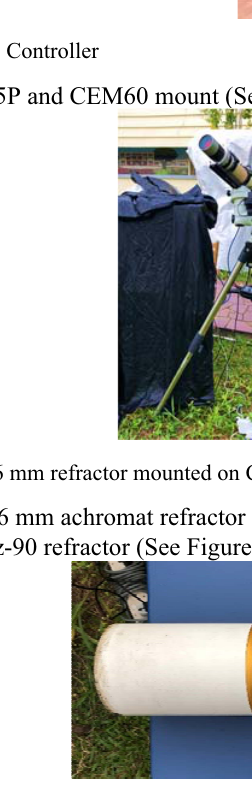
Figure 3 . Megrez-90 Refractor (cid:2) White Light filter (See Figure 4)